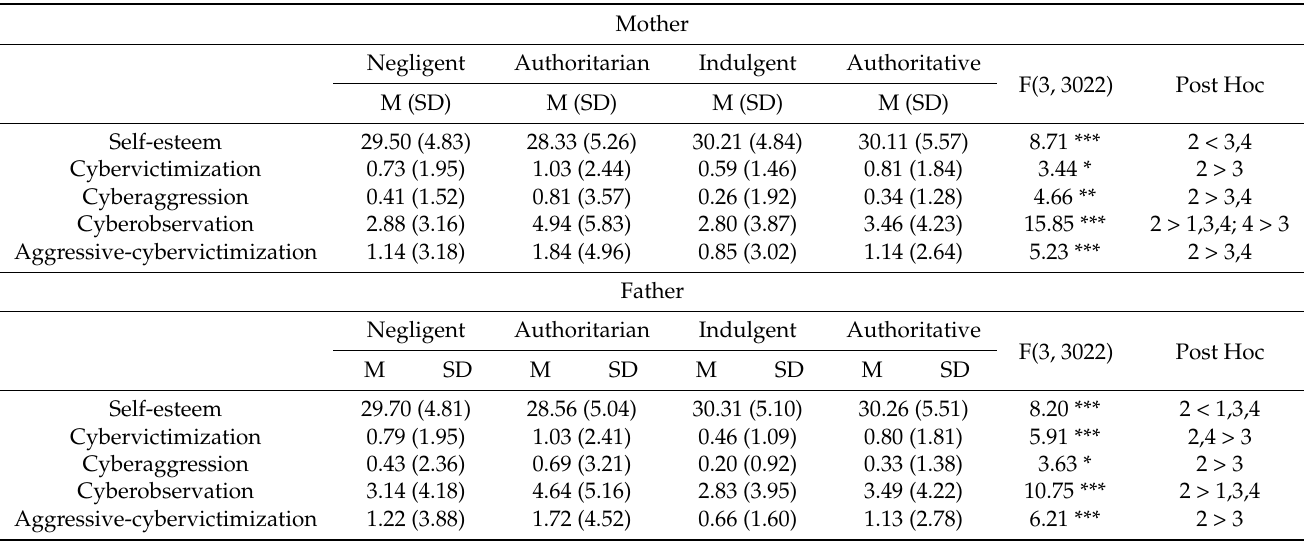
Table 3. Means, standard deviations, analysis of variance, and post hoc (Bonferroni) analysis of the parenting styles with self-esteem and with indicators of